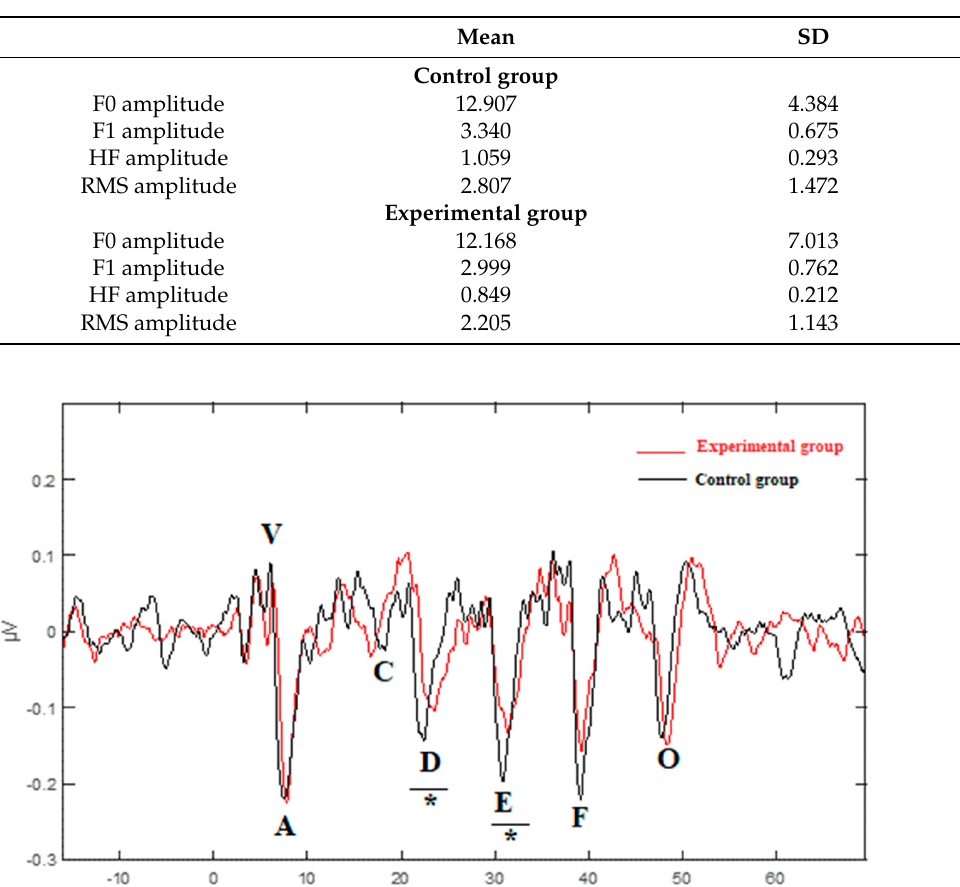
Table 4. Root mean square, F0, F1, and HF amplitudes.